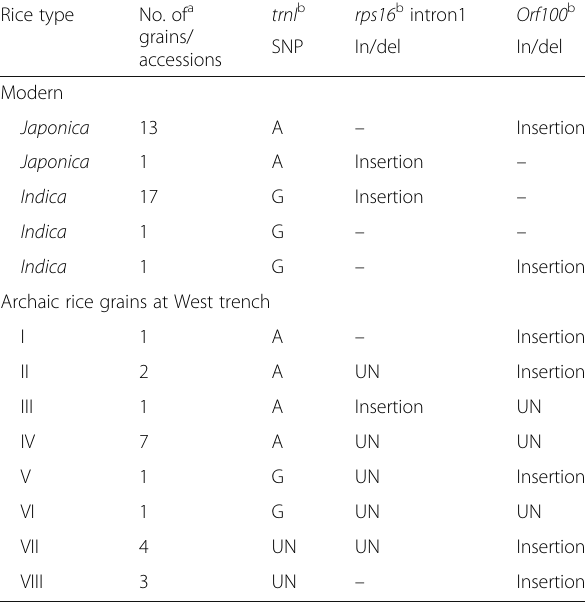
Table 5 Classification by sequence type in chloroplast genome regions Rice